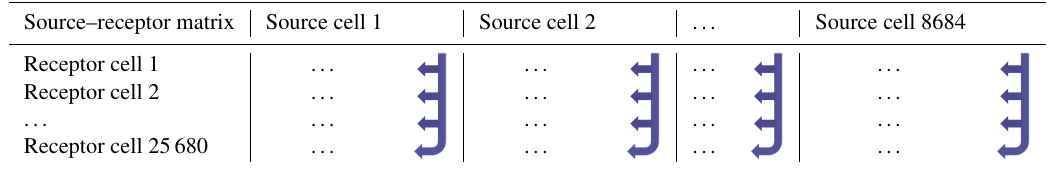
Table 1. Exemplary source–receptor (evaporation–precipitation) matrix – source cells refer to considered land cells only, whereas receptor cells cover all grid cells between 79.5 ◦ N and 79.5 ◦ S